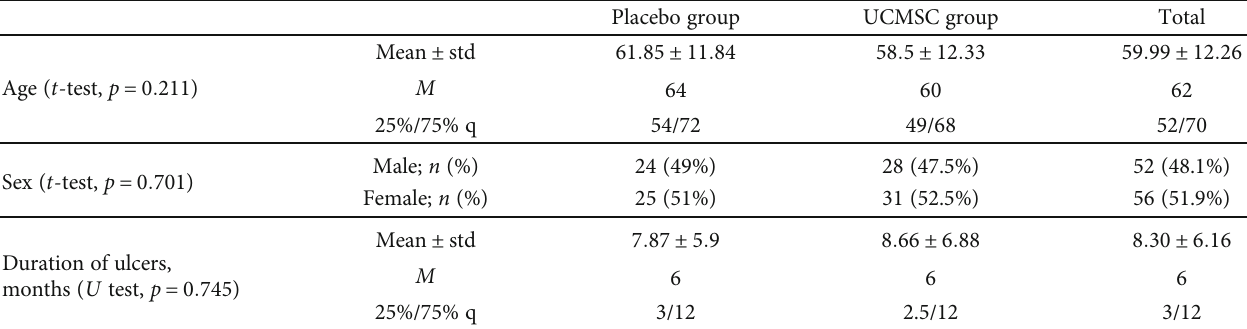
Table 2: The composition of patients by age, sex, and duration of ulcer disease in both groups. Placebo group UCMSC